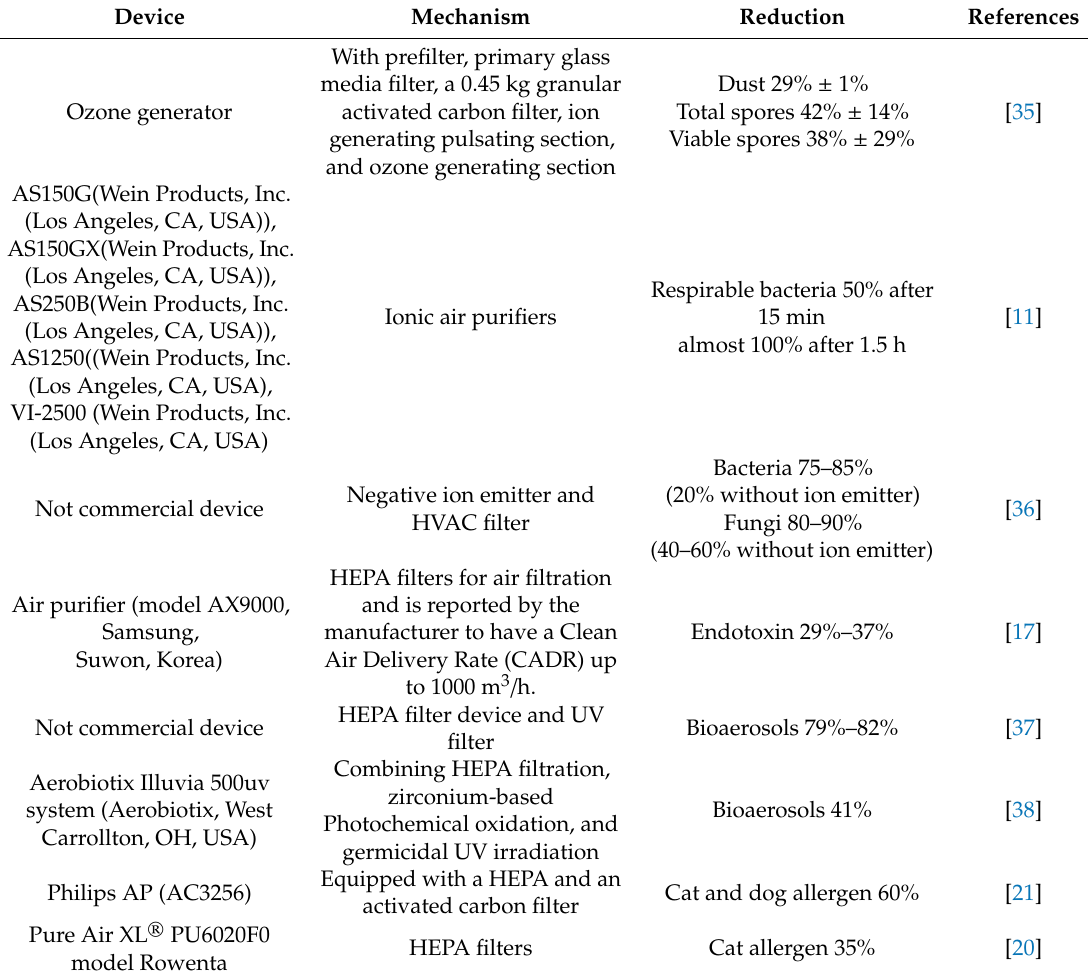
Table 1. Selected air cleaning